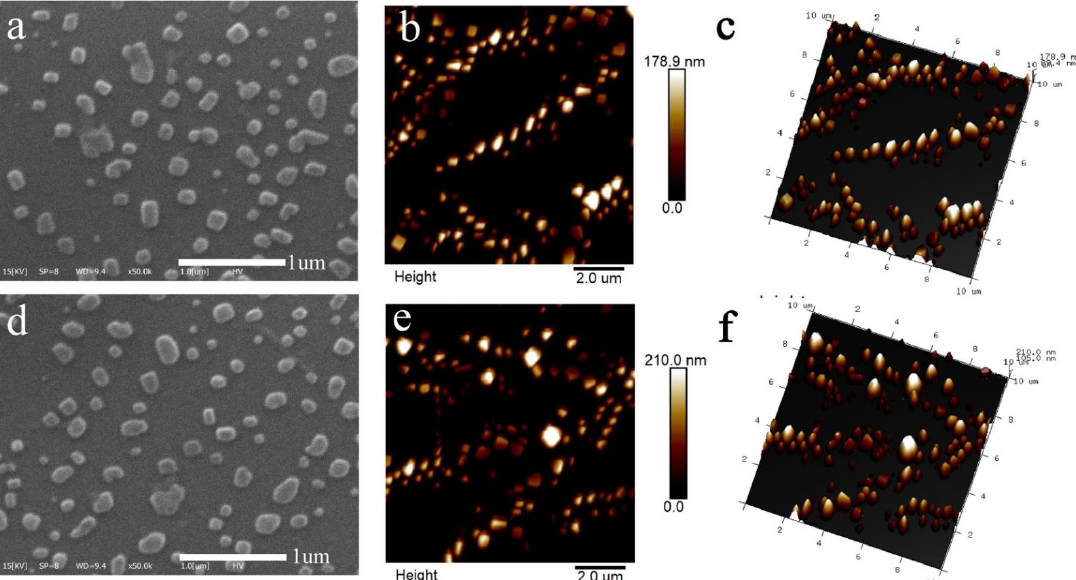
Figure 1. The morphology of nanoparticles including SEM-micrographs and surface, 3-Dimensional AFM images of RNNP ( a – c ) and TNP ( d – f